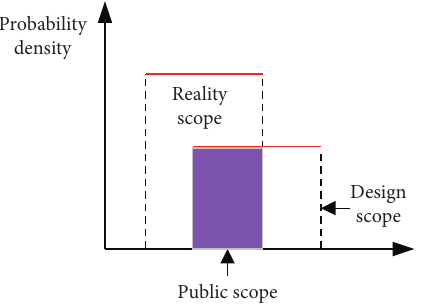
Figure 5: Basic division of housing in the axiomatic design.